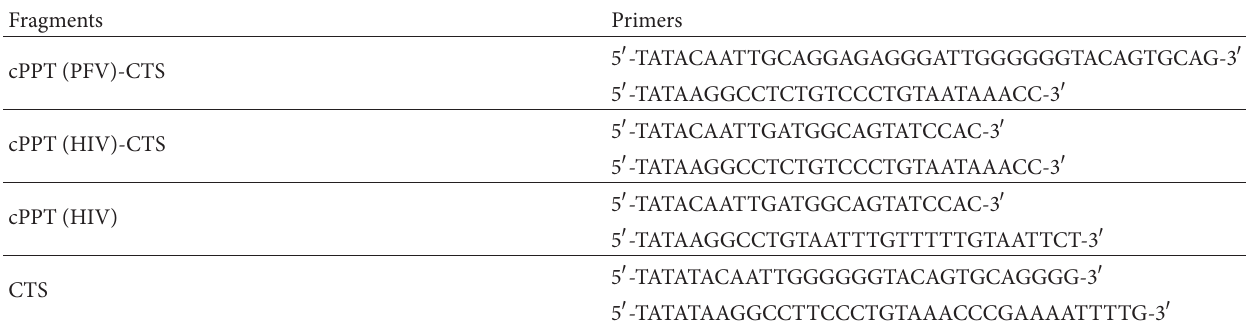
Table 2: Forward and reverse primers for a PCR amplification of the fragments used in the construction of modified expression vectors.